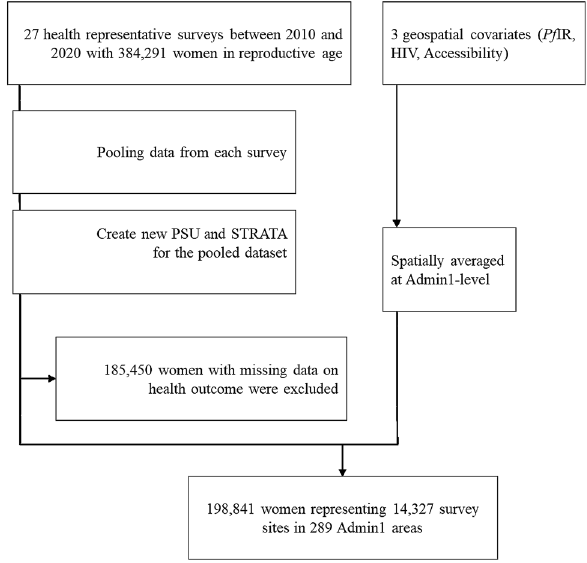
Figure 1. Flowchart of data identification, extraction and curation. PSU = Primary sampling unit, P f IR = Plasmodium falciparum incidence